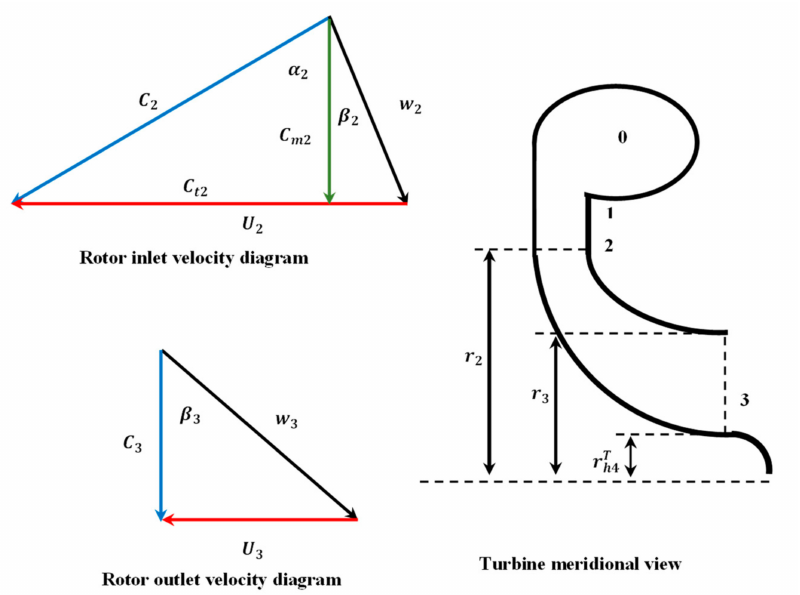
Figure 1. Velocity triangles with negative incident angle.